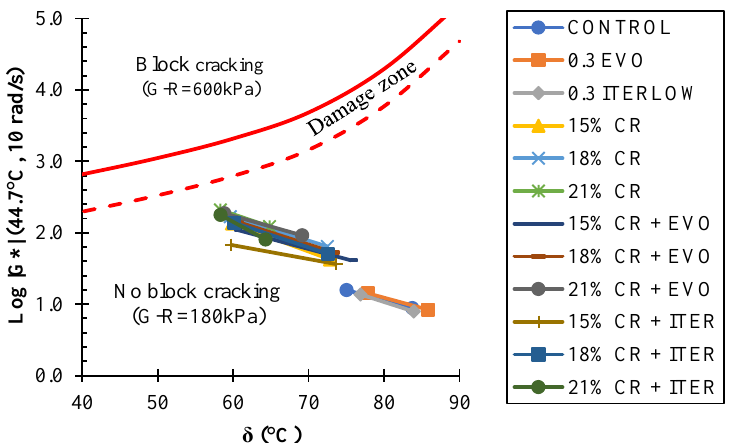
Figure 13. Black diagram for G – R parameter.